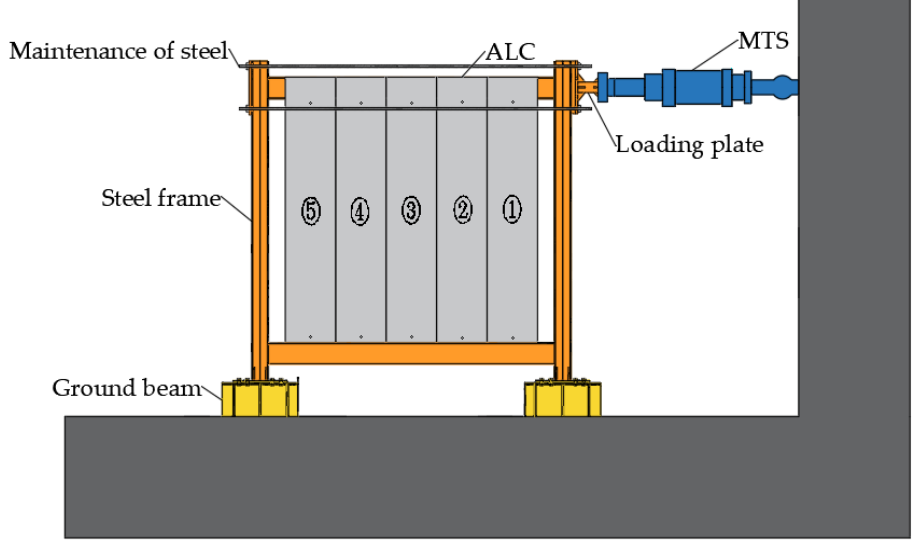
Figure 10. Schematic of test working conditions.